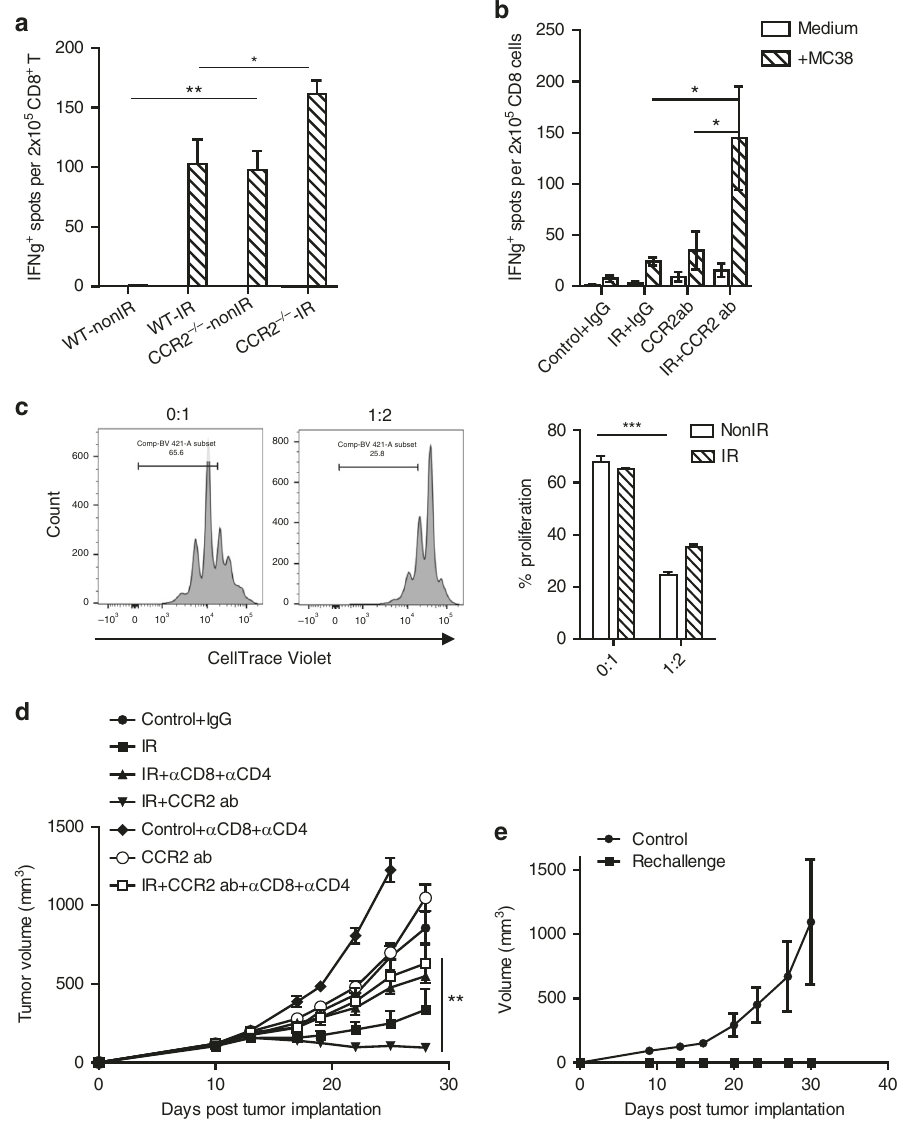
Fig. 4 Depletion of CCR2 + Ly6C hi cells enhances adaptive T cell response, which is pivotal for the ef fi cacy of IR + CCR2 ab treatment. a CD8 + T cells were puri fi ed from draining lymph nodes from WT and CCR2 − / − tumor bearing mice or WT mice that received indicated treatments, and b subjected to ELISPOT assay. c CCR2 + Ly6c hi cells were sorted from excised tumors and subjected to suppression assay. Ratio indicates CCR2 + Ly6c hi : CD8. d Depleting T cells abolished the therapeutic effect of the IR + anti-CCR2 treatment. e Mice that completely rejected MC38 tumors were re-challenged two months later by fi ve million of MC38 cells in the fl anks ( n = 5); * P < 0.05; ** P < 0.01; *** P < 0.001; Each experiment was repeated three times. Data are presented as mean ±